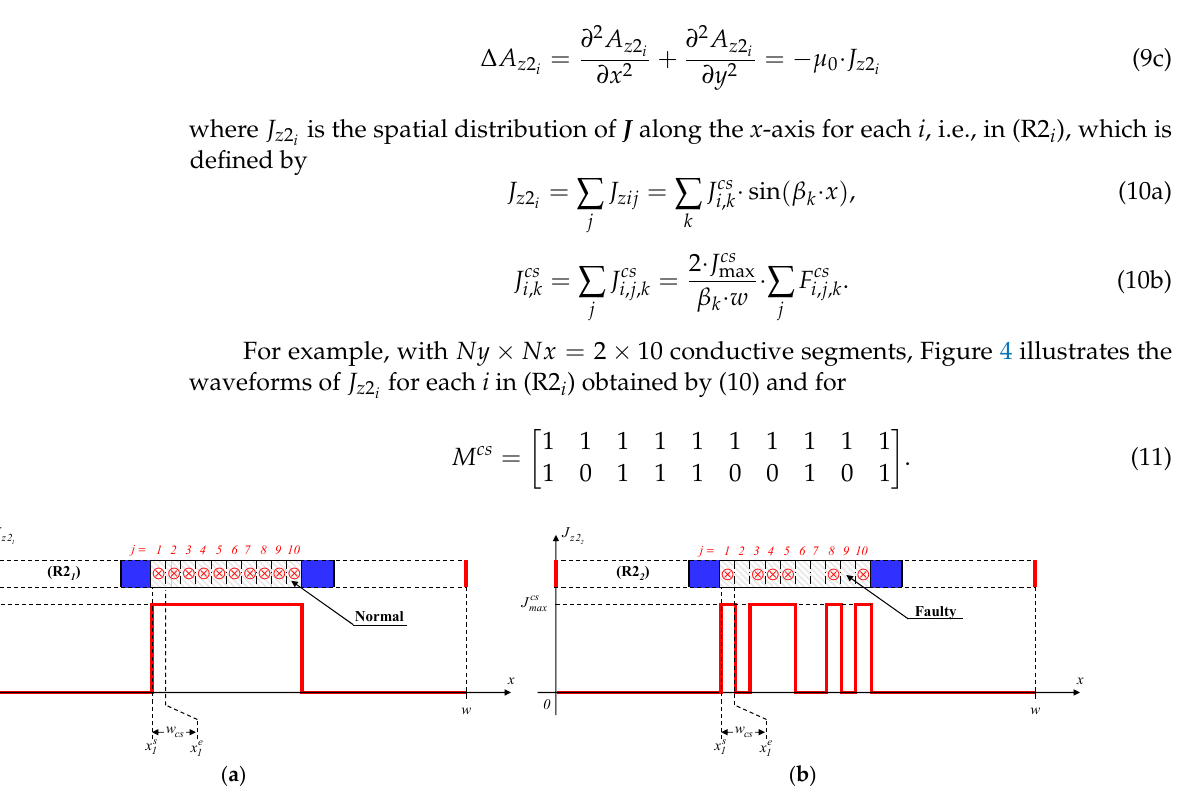
J in (R2 1 ), and ( b ) in (R2 1 ), and ( b ) J z 2 1 z2 1